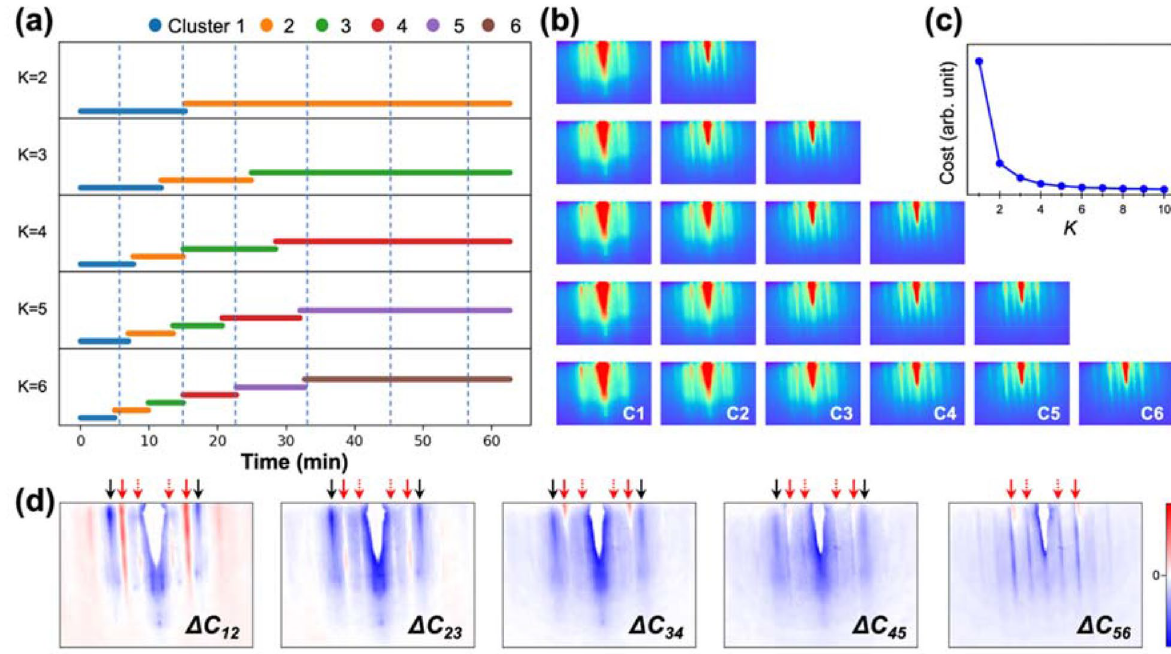
Fig. 4 K‑means clustering analysis of the RHEED video of the 3UC ReSe 2 . a Clusters with number of clusters ( K centroids. c Cost function as a function of K . d Difference between the adjacent centroids for K